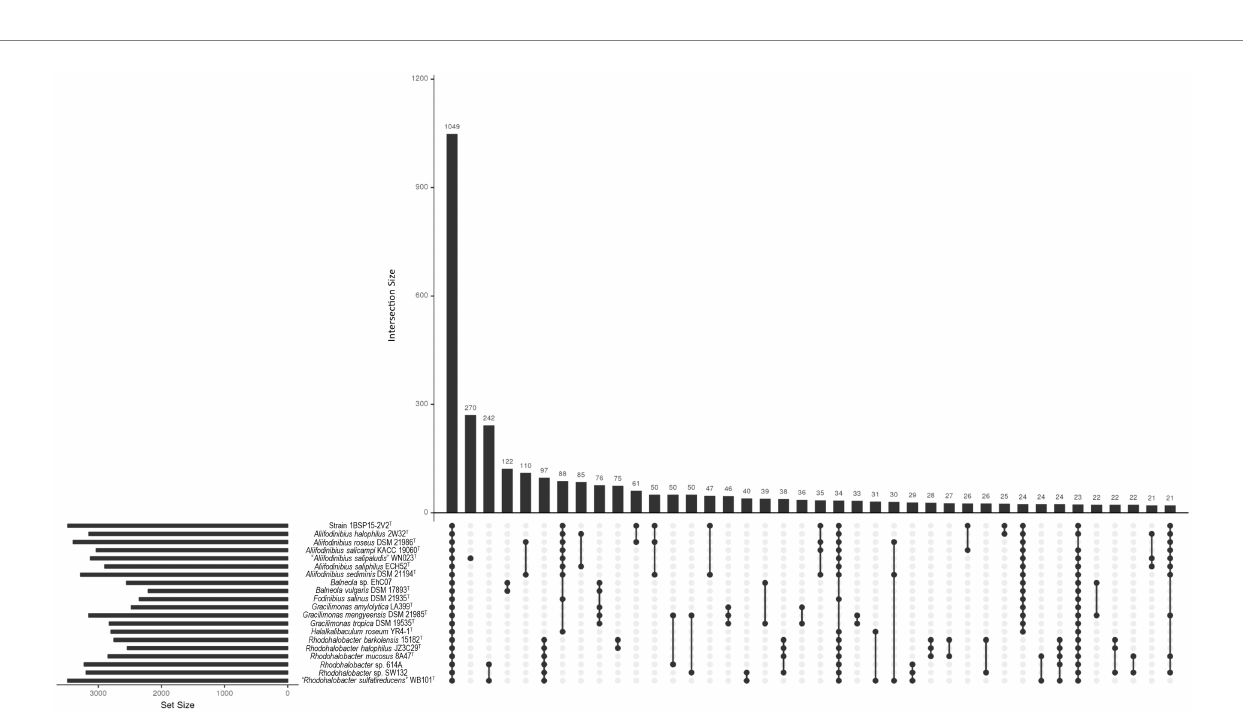
FIGURE 6 Upset plot showing the proteins shared among the 20 Balneolaceae genomes under study. Only the 40 most frequent intersecting sets are displayed. From a pan genome of 8,113 translated genes, 1,049 were encoded in all the genomes (core genome). “ Aliifodinibius salipaludis ” WN023 T harbored the highest number of unique translated genes (270). The closely related genera Aliifodinibius , Fodinibius , and Halalkalibaculum shared 88 translated